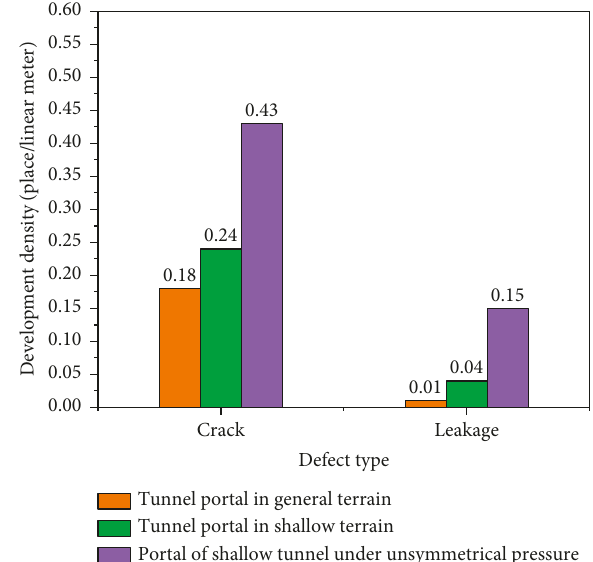
Figure 1: Statistical analysis on development density of operating tunnel defects. Figure 2: Statistical analysis on defect development density at the tunnel portal.